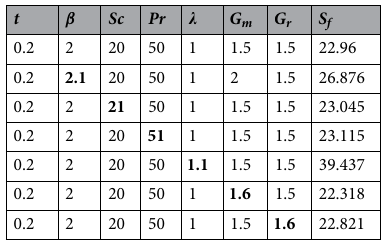
Table 1. Skin friction of the couple stress Casson fluid at the plate y = 0 for α = 0.2 . Significance values are in Bold.